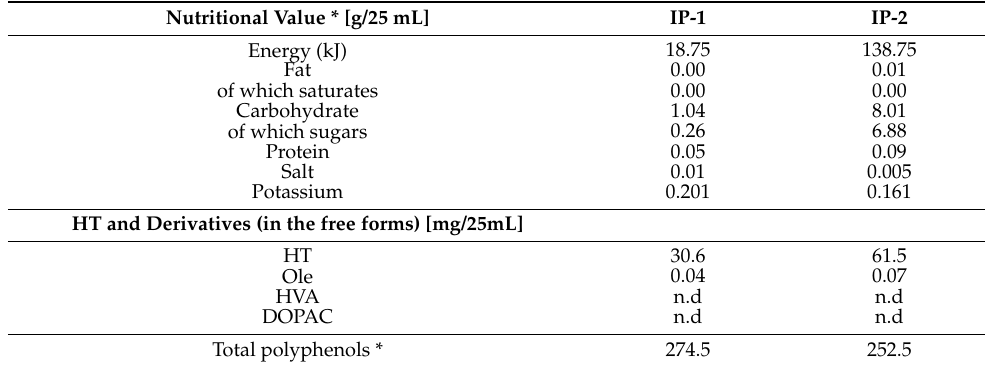
Table 1. Nutritional value and content of hydroxytyrosol (HT) and derivatives in one flask (25 mL) of the food supplements. Ole: oleuropein, HVA: homovanillic acid, DOPAC: 3,4-dihydroxyphenylacetic acid. n.d.: not detectable; *: according to producer.